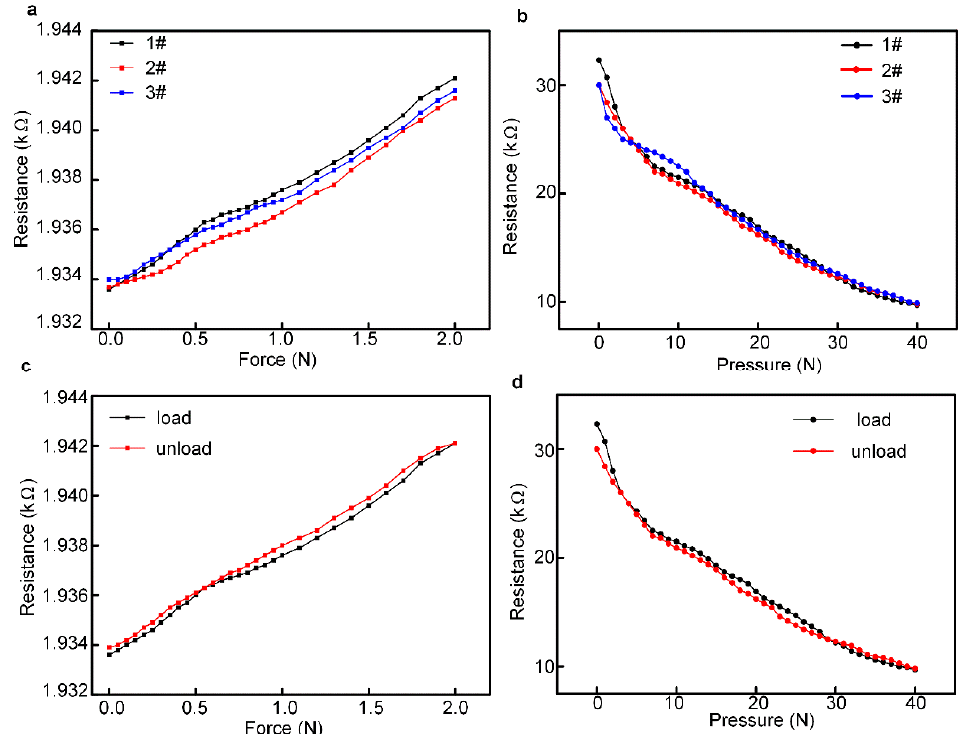
Figure 8. The repeatability and hysteresis properties of the tactile and pressure sensor, and 1#, 2# and 3# represent the first, second and thired sensors. means the ( a ) The repeatability property of the tactile sensor. ( b ) The repeatability property of the pressure sensor. ( c ) The hysteresis property of the tactile sensor. ( d ) The hysteresis property of the pressure sensor.